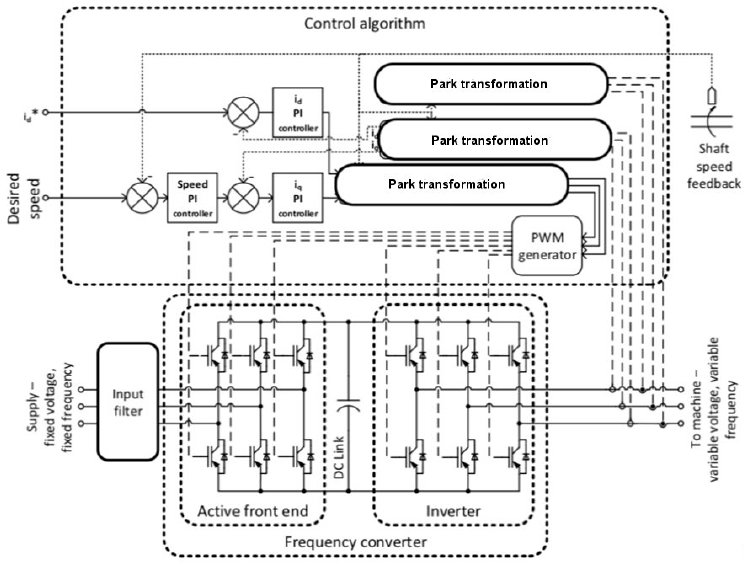
Figure 2. VSI with a Active Front End layout and relative control loops.